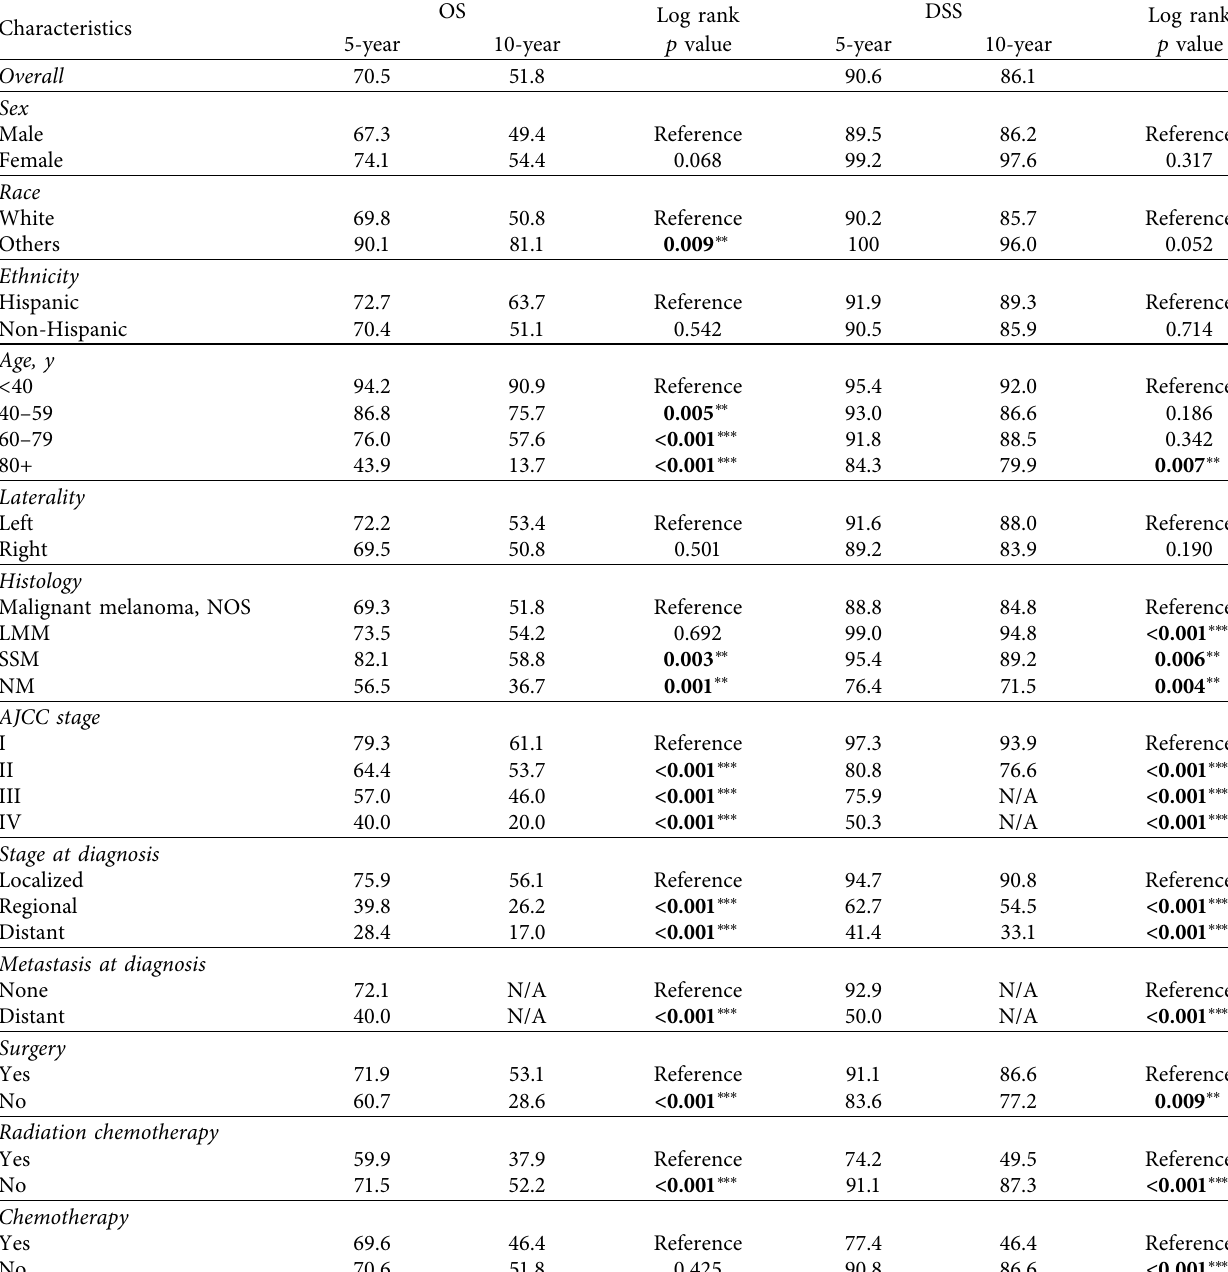
Table 2: Univariate analysis of factors affecting 5-year and 10-year OS and DSS of eyelid PMM.